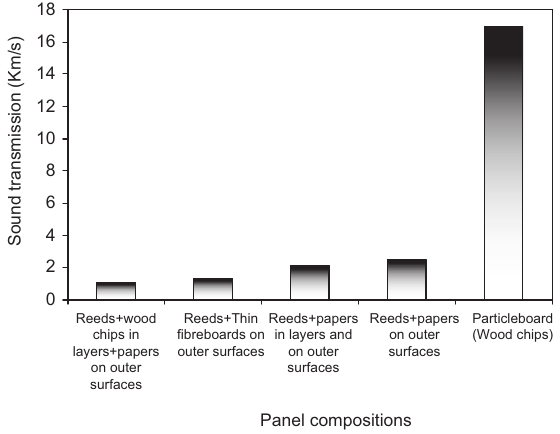
Figure 2 Sound transmission of panels made from reed mats and some other materials.